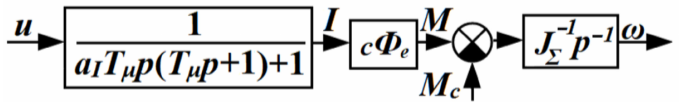
Figure 2. Plant of DC drive speed control loop.